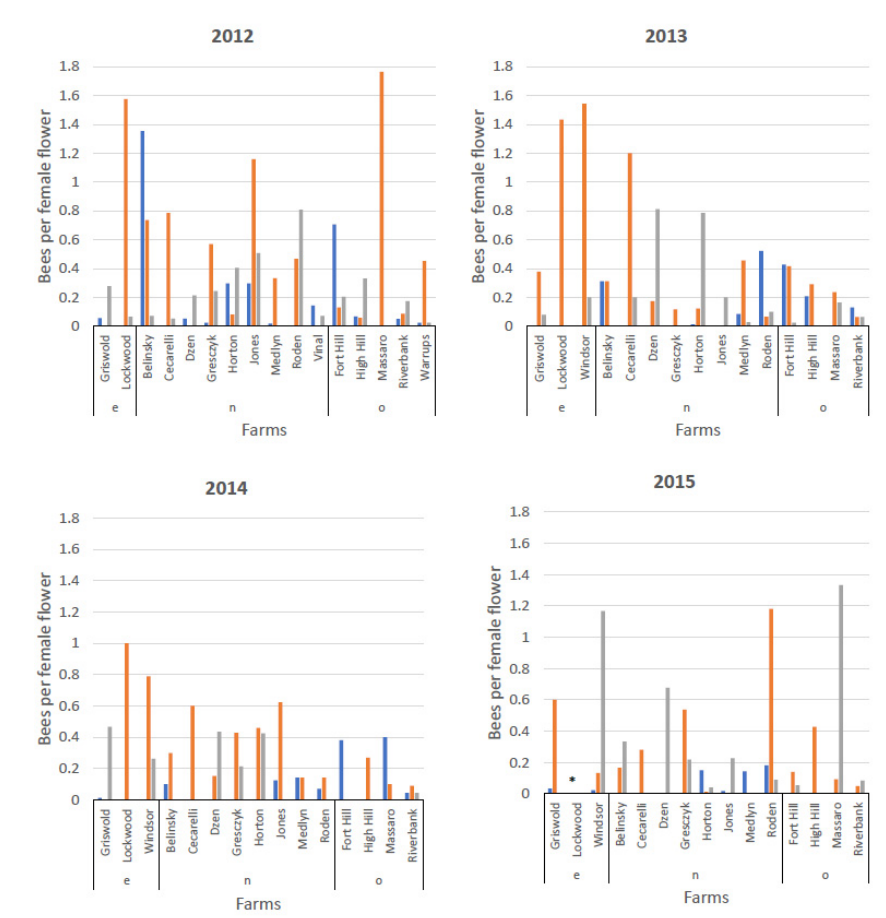
Figure 3. Bees by species per female flower in hourly 100 flower bee counts by farm and by year. Blue = squash bees, orange = bumble bees, and gray = honey bees; e = experimental farms, n = non-organic farms, and o = organic farms. * Lockwood in 2015 did not have any female flowers among the samples counted.